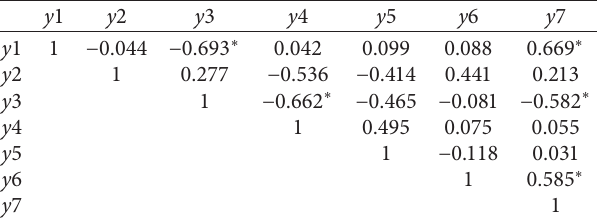
Table 3: Pearson correlation of chemical compositions and anti- oxidant capacities of FWGE.